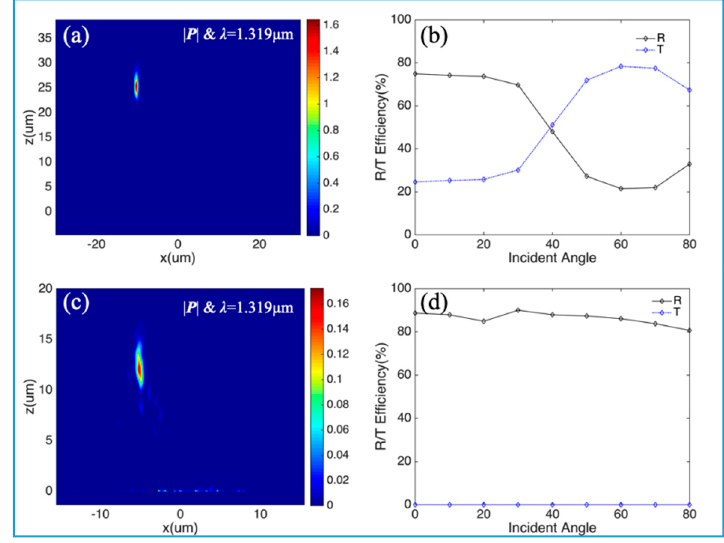
Figure 6. Large-FOV focusing of meta-reflectors: ( a ) Focal profile of light with an incident angle 20°, which is reflected by the meta-reflector with DBR as a bottom mirror in Figure 4a; ( b ) Reflectance and Transmittance of light with different incident angles from 0° to 80°, which is reflected by the meta-reflector in ( a ); ( c ) Focal profile of light with an incident angle 20°, which is reflected by the meta-reflector with Au film as a bottom mirror in Figure 5a; ( d ) Reflectance and Transmittance of light with different incident angles from 0° to 80°, which is reflected by the meta-reflector in ( c ).